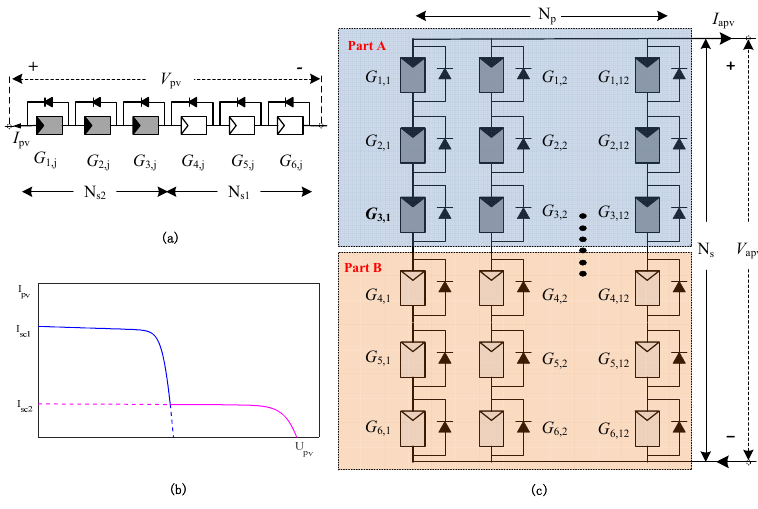
Figure 2. Schematic model of PV array: ( a ) PV substring under shading condition; ( b ) V–I characteristic curve corresponding to ( a ); ( c ) PV array model.